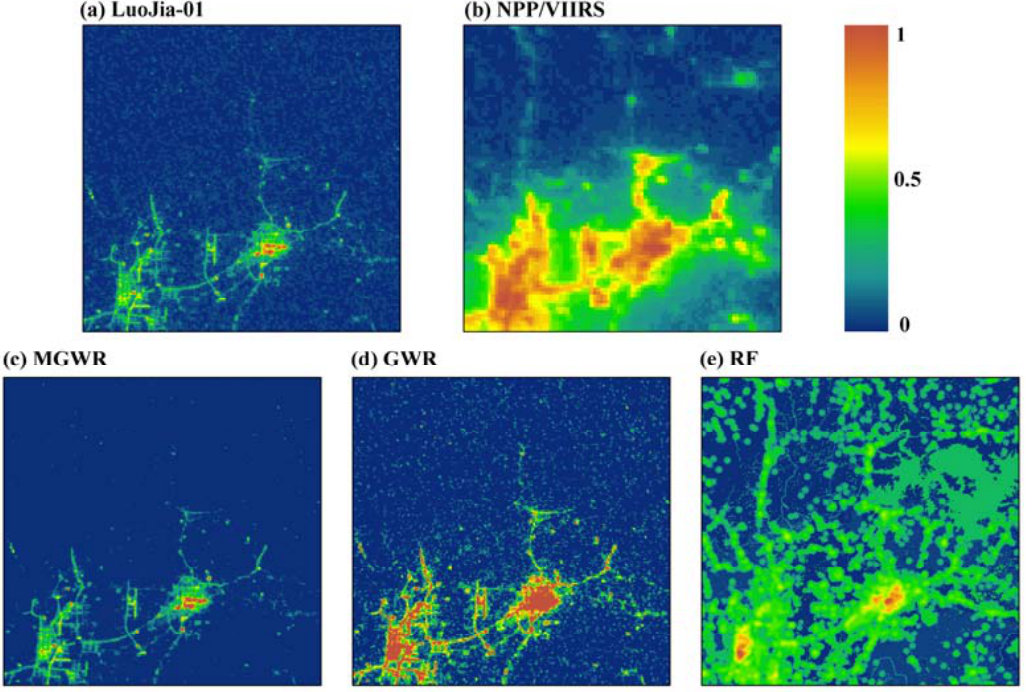
Figure 7. Spatial images comparing of the results of the three downscaling methods in the HR region, ( a ) LuoJia-01, ( b ) NPP/VIIRS, ( c ) MGWR, ( d ) GWR, ( e ) RF. (Spatial resolution: 500 m; study period: September 2018).